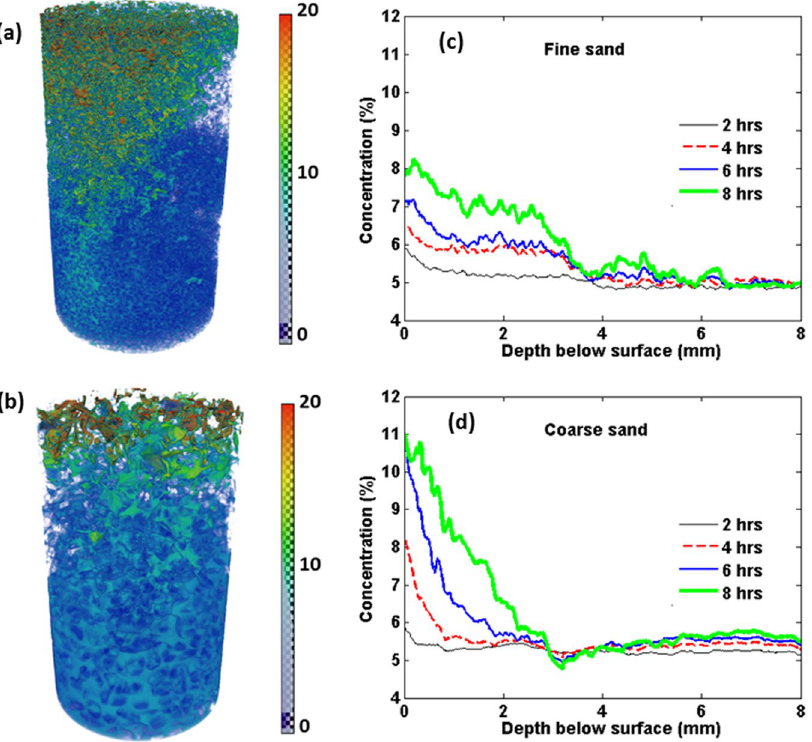
Figure 4. Reconstruction of the liquid phase in the top 5 mm of the ( a ) fine and ( b ) coarse sand 8 hours after the onset of evaporation with the colour map representing the solute concentration percentages. Colours closer to red indicate higher concentrations. Also presented is the dynamics of solute distribution in ( c ) fine and ( d ) coarse sand at various times from the onset of the experiments (indicated in the